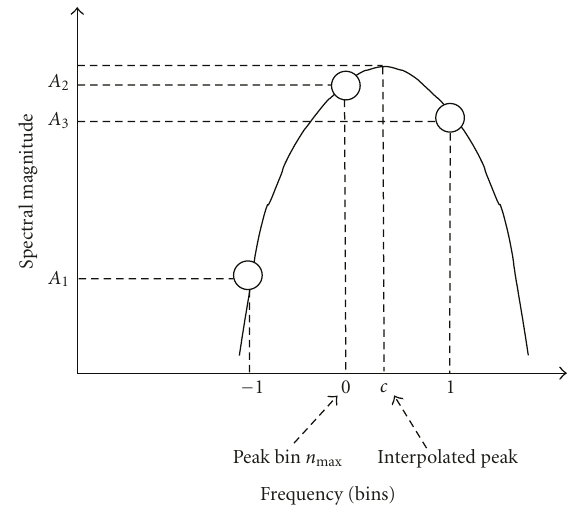
Figure 2: Parabolic fitting between three FFT bins.